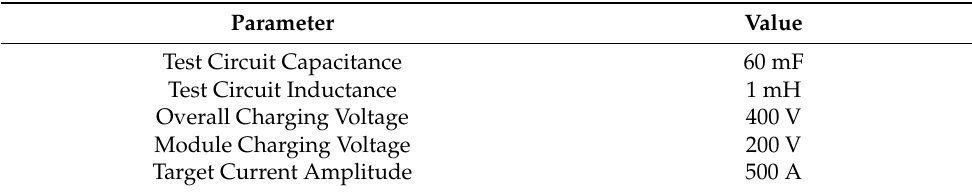
Table 2. Values of testing parameters for presented experimental investigation of interconnection designs from Figure